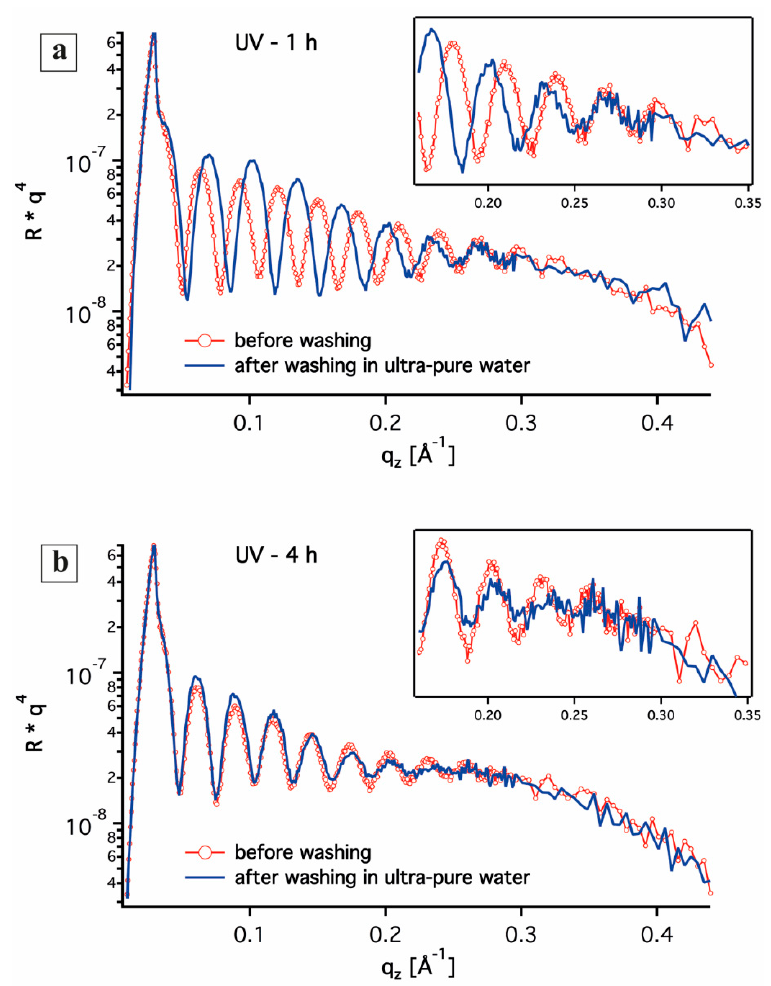
Figure 8. X-ray reflectivity curves of PS-h ν -PEO ultra-thin film UV-cleaved for 1 h ( a ) and 4 h ( b ) before (red markers) and after washing in ultra-pure water (blue line). The curves are plotted as R ∗ q 4 versus q z to eliminate the strong drop of the reflectivity and to enhance the visibility of the Kiessig fringes.